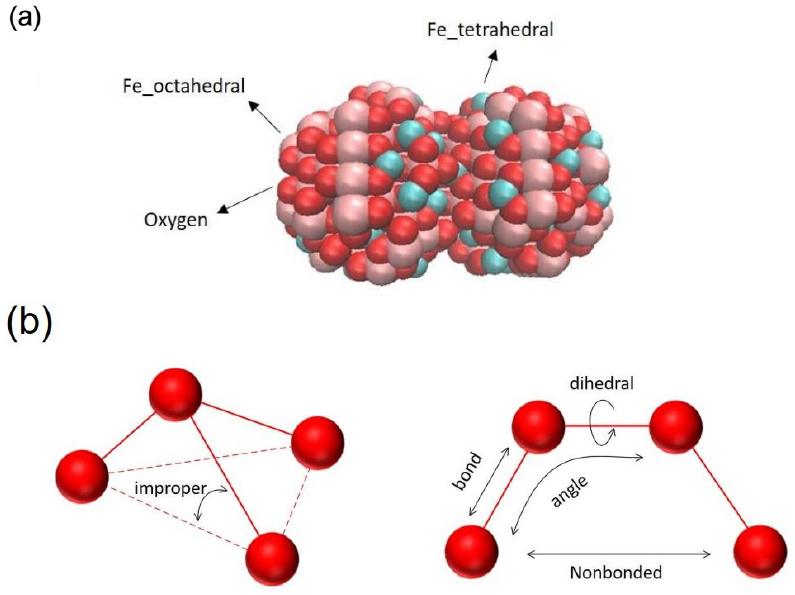
Figure 5. ( a ) Two 1 nm radius Fe 3 O 4 nanoparticles attached to each other. Red atoms are oxy- gen, pink atoms are Fe octahedral , and cyan atoms are Fe tetrahedral , ( b ) schematic of the forces and atoms